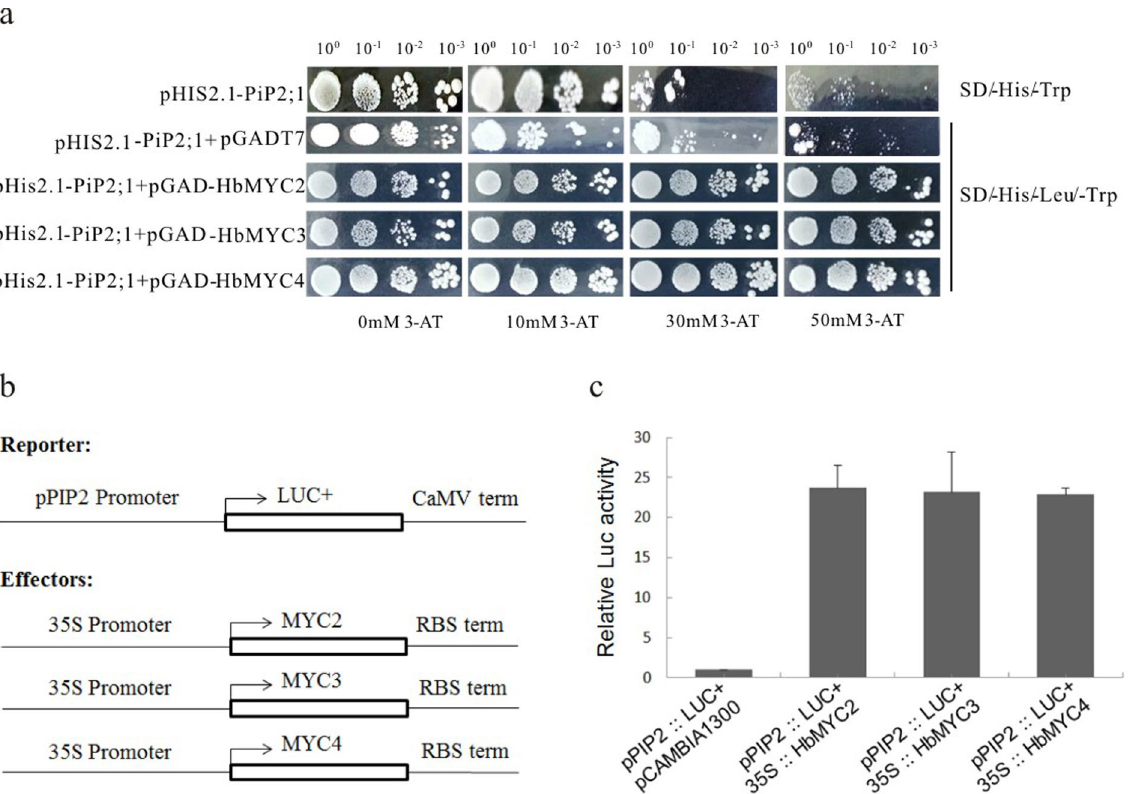
Figure 6. HbMYC2/3/4 bind the promoter and regulate the expression of the HbPIP2;1-P gene. ( a ). The pGADT7- HbMYC2 , pGADT7- HbMYC3 , pGADT7- HbMYC4 plasmids were transformed into Y187 Gold strains containing pHis2.1-PIP-P, after which the strains were cultured in SD/-His/-Leu/-Trp + 3-AT media at 30 °C for 3–5 days. ( b ) Schematic diagram of the reporter and effector constructs used in the luciferase assay. The firefly luciferase (LUC) reporter was driven by the HbPIP2;1 promoter, and HbMYC2/3/4 were driven by the CaMV 35 S promoter in each of the effector constructs. c . Luciferase assay of the enhancement of the HbPIP2;1 promoter activity by the overexpression of HbMYC2, HbMYC3, and HbMYC4 in protoplasts. The pPIP2:LUC reporter and respective 35 S: MYC2/3/4 effector constructs as well as empty vector controls were co- transformed into Arabidopsis protoplasts. Luciferase activities were quantified using a dual-luciferase assay kit (Promega, USA) and detected by using a GloMax ® 96 microplate luminometer (Promega, USA). The values are the means ± SDs from the results of three